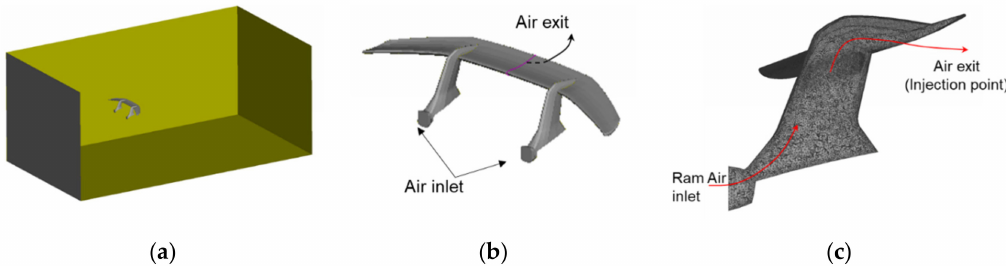
Figure 2. Shape of the simplified rear spoiler to determine the injection velocity: ( a ) Simulation domain; ( b ) Geometry and boundary conditions; ( c ) Schematic of the flow passing through the rear